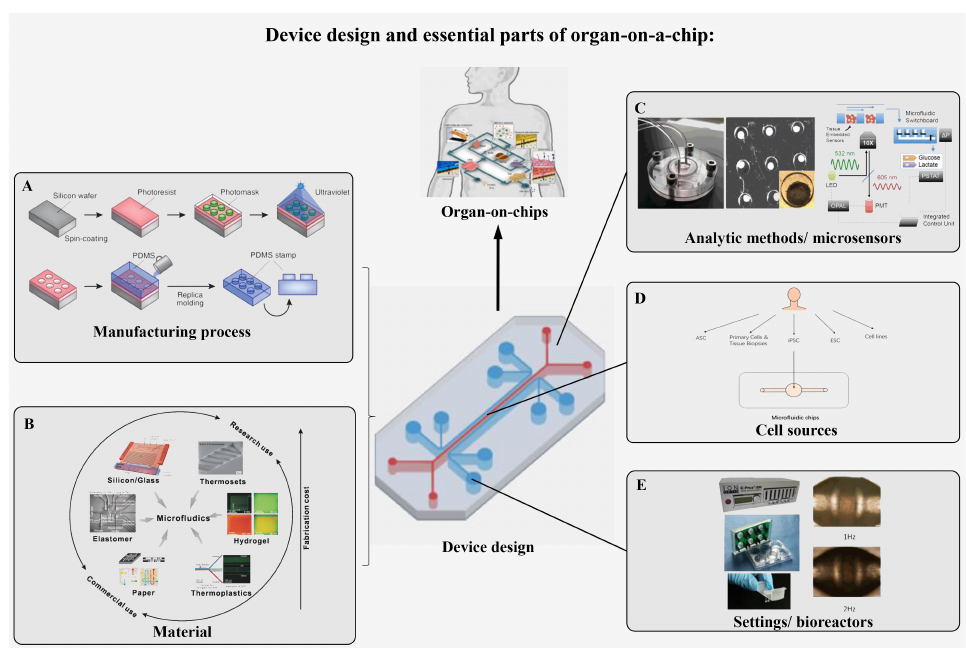
Figure 4. Schematic of device design and essential parts of OOC. ( A ) Manufacturing process of the device. A uniform layer of photosensitive material is spin-coated on the silicon wafer and then covered with a photomask with a microscale pattern. The microscale pattern etches into the photoresist after exposure to high-intensity ultraviolet light. PDMS stamps are obtained by casting the PDMS liquid prepolymer onto the etched photoresist pattern (adapted and modified from ref. [4]). ( B ) Materials of microfluidic chips (adapted and modified from ref. [49]). ( C ) A sensor system for metabolic monitoring. Nanoparticles embedded in the microtissues measure the Oxygen and pH. Aerometric biosensors downstream connected by a microfluidic switchboard measure the glucose and lactate (adapted and modified from ref. [50]). ( D ) Adult stem cells (ASCs), primary cells, cell lines, induced pluripotent stem cells (iPSCs), and embryonic stem cells (ESCs) can be differentiated and incorporated into microfluidic chips. ( E ) Cardiomyocytes are further differentiated and matured under the tension of microcantilevers and electrical stimulation, eventually achieving synchronized beating controlled by electrical